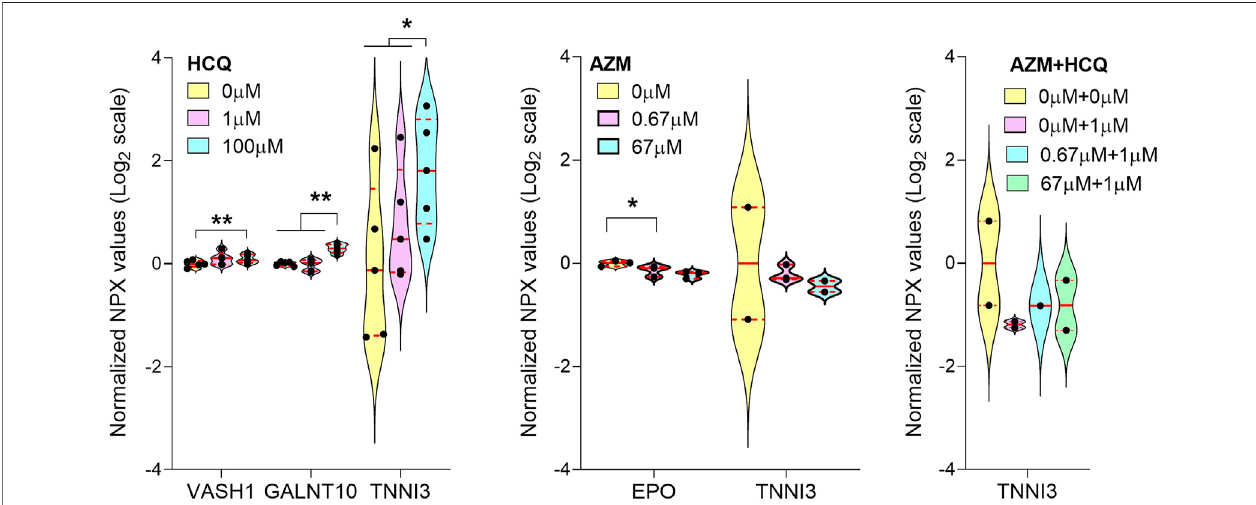
FIGURE 6 | Proteomics Analysis of MPS mono and polytherpay. Violin plot with biomarkers showing signi fi cant changes with increasing doses of HCQ alone (A) , AZM alone (B) or polytherapy dose escalation (C) . Only biomarkers with > 65% of samples above limit of detection were included. The limit of detection was set at 3 standard deviation above negative control values. Statistics run were one-way ANOVA with multiple comparison and Dunnett ’ s post-hoc correction. * p < 0.05; ** p < 0.01.